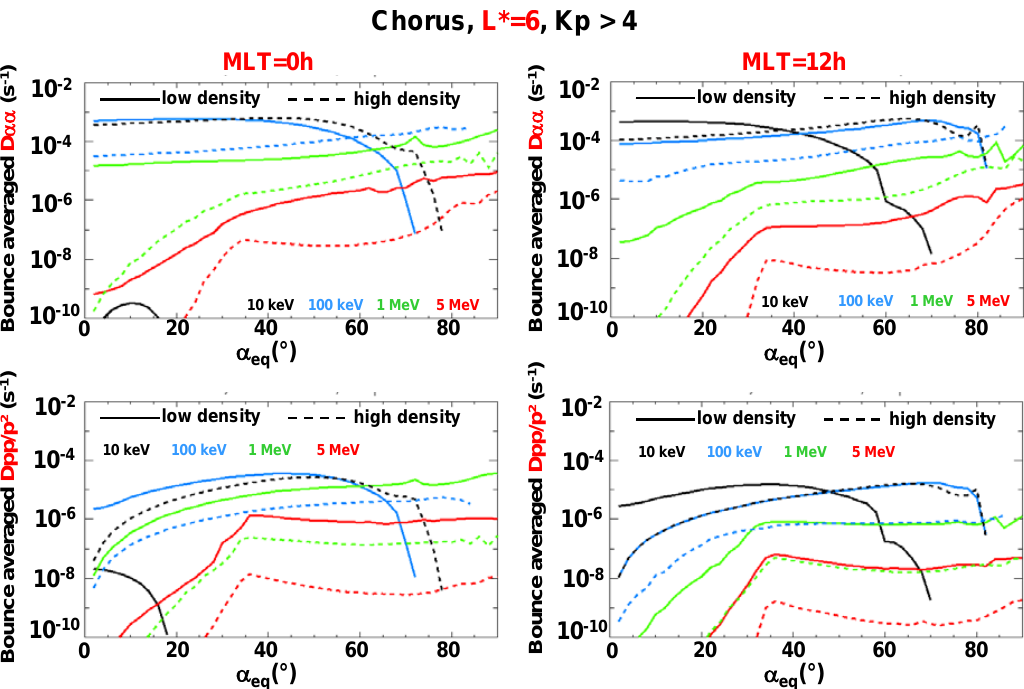
Figure 4. Bounce-averaged pitch angle (top) and energy (bottom) diffusion rates (s − 1 ) for chorus using WAPI code for 4 energies, 0.01MeV Fig. 4 Bounce-averaged pitch angle (top) and energy (bottom) diffusion rates (s -1 ) for chorus 689 (black), 0.1MeV (blue), 1MeV (green) for and 5MeV (red) L ∗ = 6 and for MLT = 0h on the left and MLT = 12h on the right for active magnetic activity (Kp > 4) and for two different plasma densities: 5th percentile in solid lines and 95th percentile in dashed using WAPI code for 4 energies, 0.01 MeV (black), 0.1 MeV (blue), 1 MeV (green) for and 5 690 MeV (red) L*=6 and for MLT=0h on the left and MLT=12h on the right for active magnetic 691 activity (Kp>4) and for two different plasma densities: 5 th percentile in solid lines and 95 th 692 percentile in dashed lines. 693